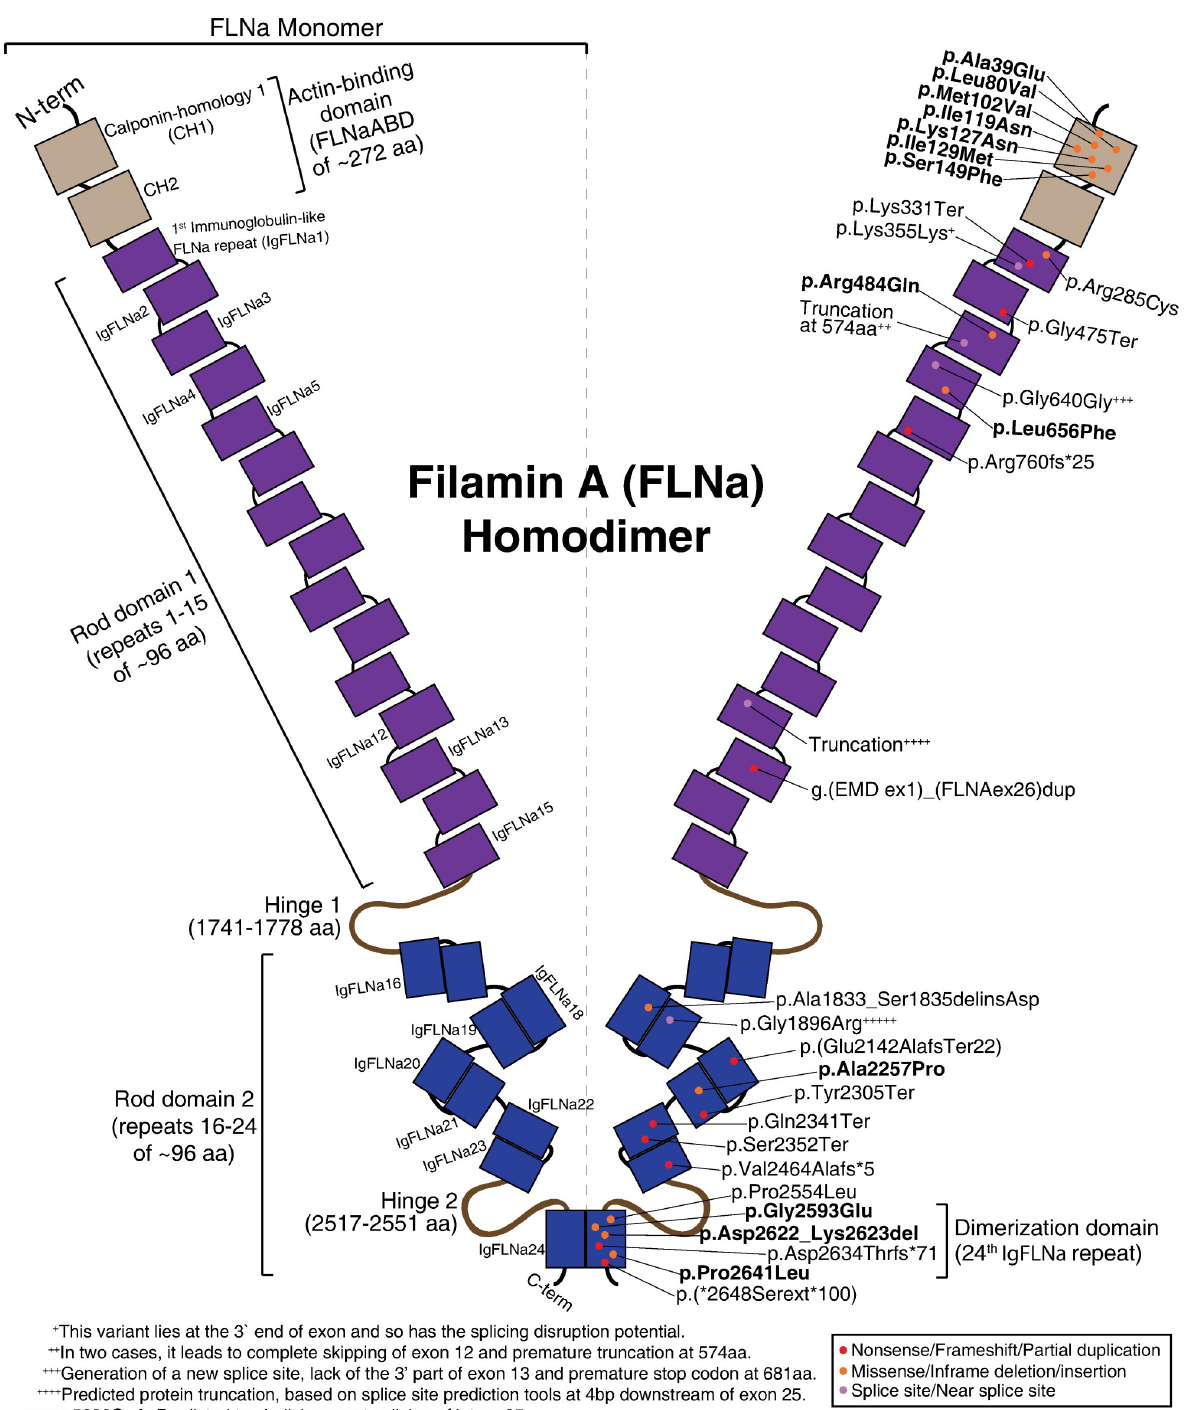
Fig 1. Schematic representation of the Filamin-A (FLNa) homodimer. The structural and functional domains, and the reported liveborn PNH male variants in the literature were represented on associated region of the structure. The variants subjected to molecular dynamics simulations are shown in bold. † aa: amino